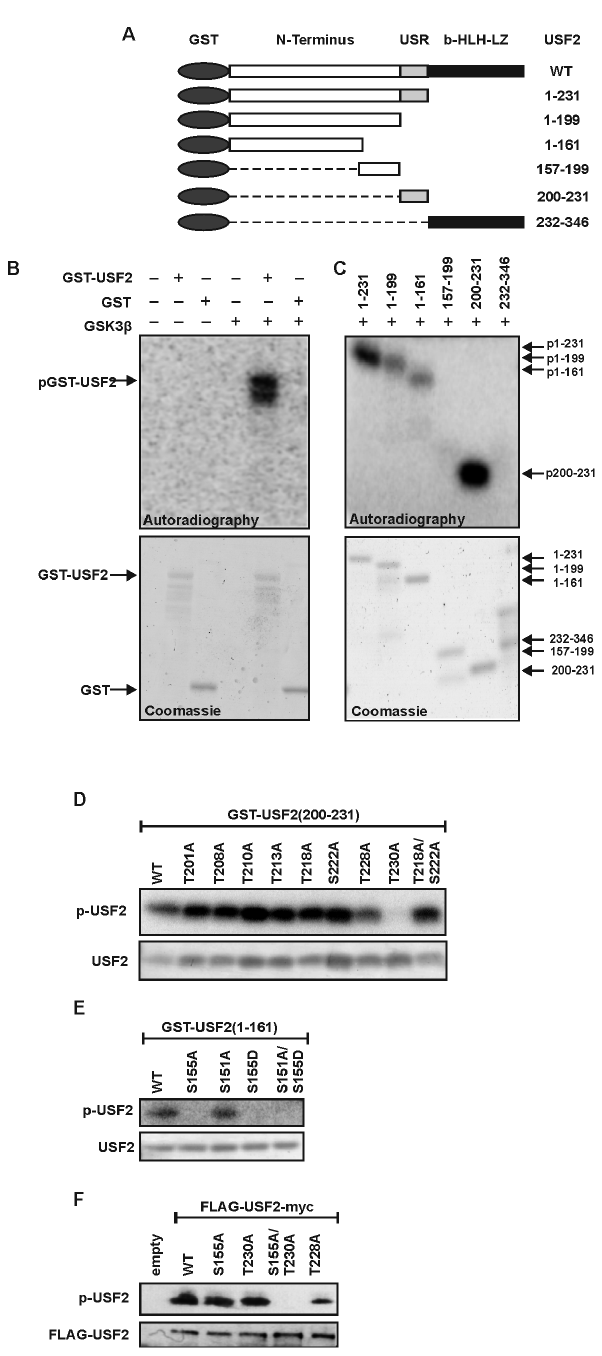
Figure 2. GSK3 b -mediated phosphorylation occurs in two USF2 domains. (A) Schematic representation of the USF2 deletion mutants used to identify the domains that are phosphorylated by GSK3 b . (B–E) Purified GST-tagged USF2 proteins were incubated with recombinant human GSK3 b in the presence of [ c 2 32 P] ATP. Proteins were separated by SDS-PAGE and incorporated radioactivity was detected by autora- diography. The total amount of proteins was detected by Coomassie staining. (F) HeLa cells were transfected with expression vectors for USF2 or the empty vector. USF2 was immunoprecipitated from the total cell extract and then incubated with recombinant human GSK3 b in the presence of [ c 2 32 P] ATP. Proteins were separated by SDS-PAGE and incorporated radioactivity was detected by autoradiography. The total amount of proteins was detected by silver staining.